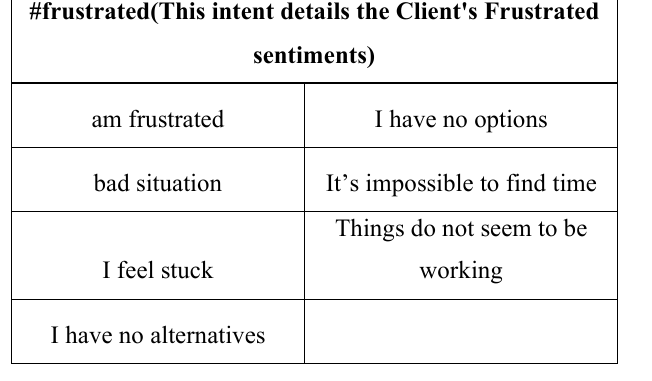
Table 12. Intent #Focusing Details and case examples configured